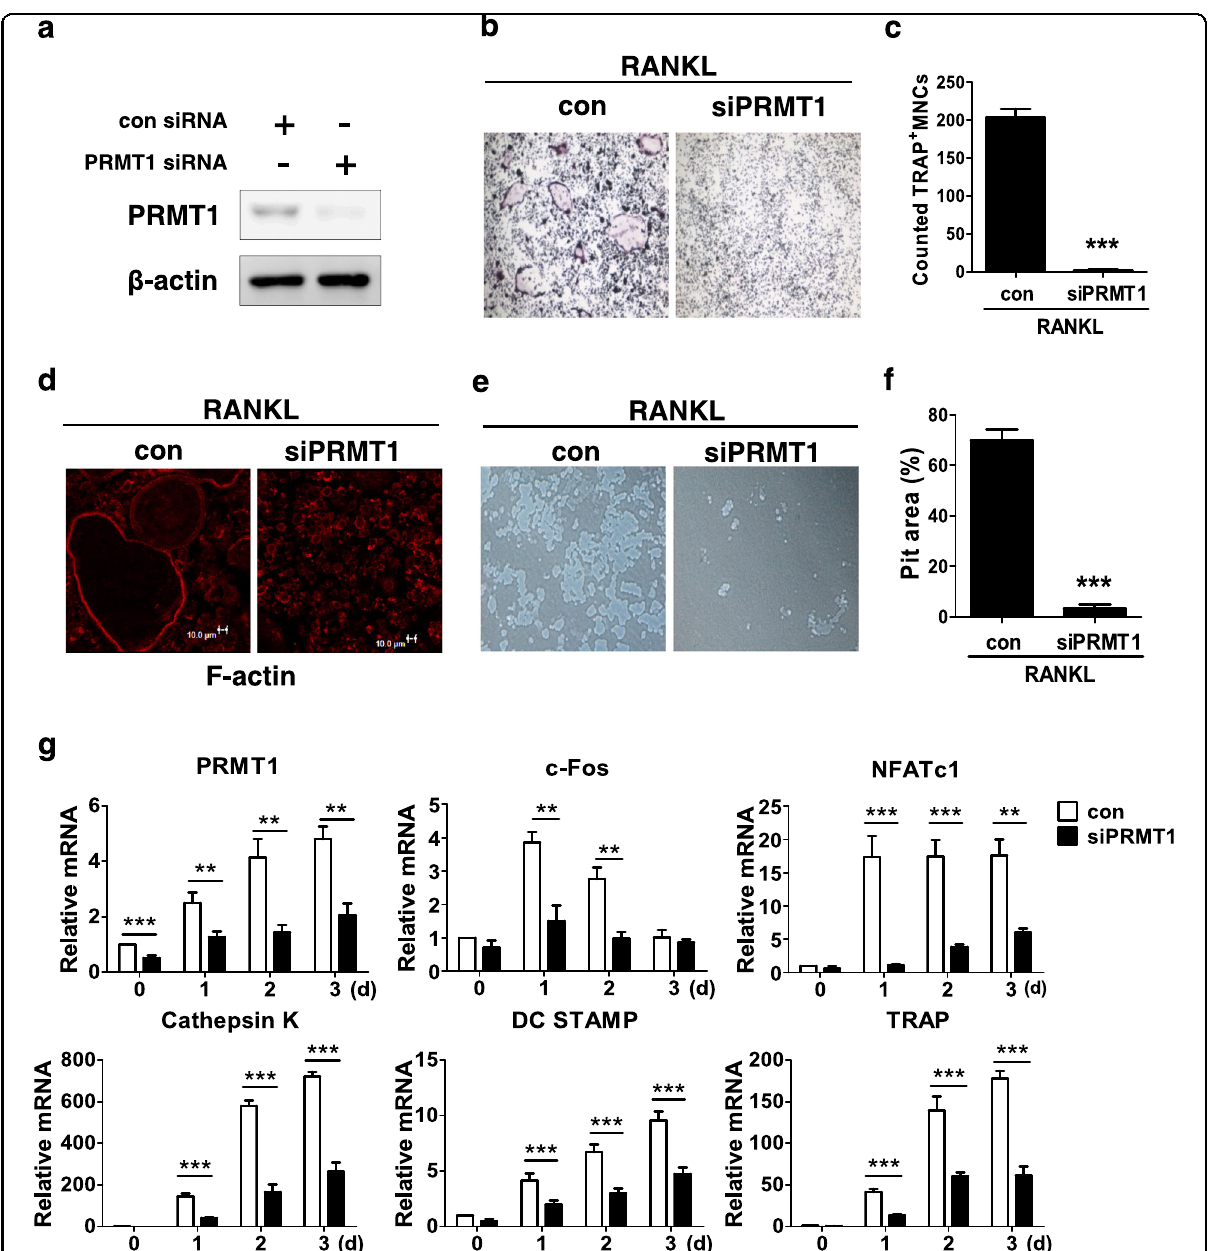
Fig. 2 PRMT1 knockdown attenuates RANKL-induced osteoclast function. a-g BMDMs were transfected with control siRNA (con) or PRMT1 siRNA (siPRMT1) according to the forward transfection method for 2 days, and these transfected cells were incubated with RANKL (100 ng/ml) in the presence of M-CSF (30 ng/ml) for an additional 3 days. a The cell extracts were subjected to a western blot analysis with PRMT1 and β -actin antibodies. b , c The cells were stained for TRAP activity, and the TRAP-positive multinucleated cells were counted to determine osteoclast numbers. d The cells were fi xed and stained with Alexa Fluor 594-phalloidin for F-actin. e , f The cells were cultured on an Osteo Assay Surface Plate for 3 days and then removed. Resorption pits were visualized under light microscopy, and the percentage was obtained using the image J program. Representative images are from at least three independent experiments. g Total RNA was extracted from the cells, and the levels of the indicated mRNAs were measured using real-time PCR. The results are normalized to the β -actin level. The results are expressed as the mean ± SD. ** p < 0.01, *** p <